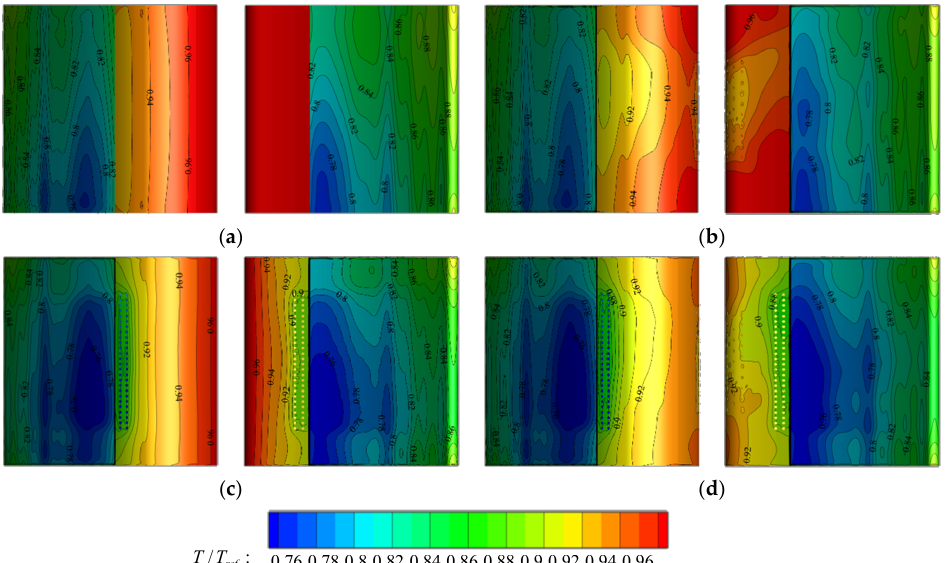
Figure 5. Temperature comparisons for different cases ( T ref = 701 K). ( a ) uncoated vane without film, ( b ) uncoated vane with LE film, ( c ) uncoated vane with downstream film, ( d ) uncoated vane with LE and downstream film.